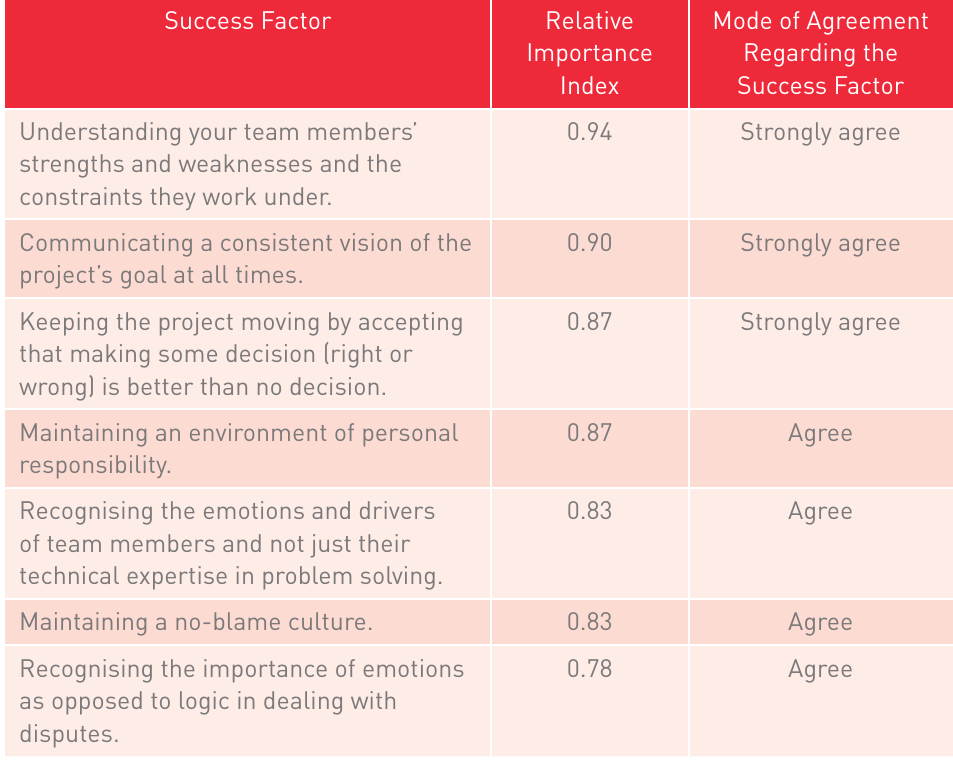
The consensus position of panel members on commentary regarding success factors associated with team management